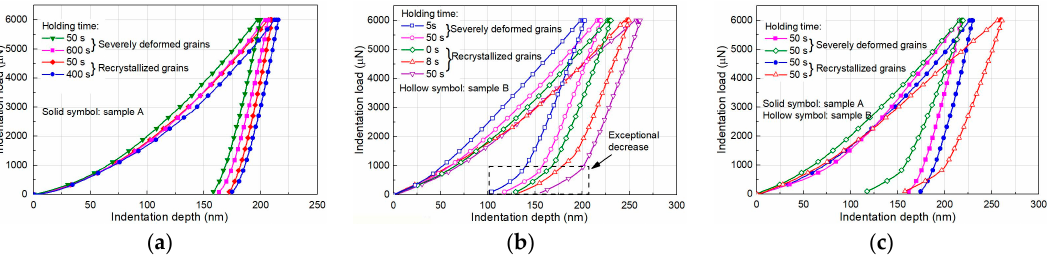
Figure 7. Indentation load versus indentation depth curves of samples at different holding times: ( a ) sample A; ( b ) sample B; ( c ) sample A and sample B at the same holding time.